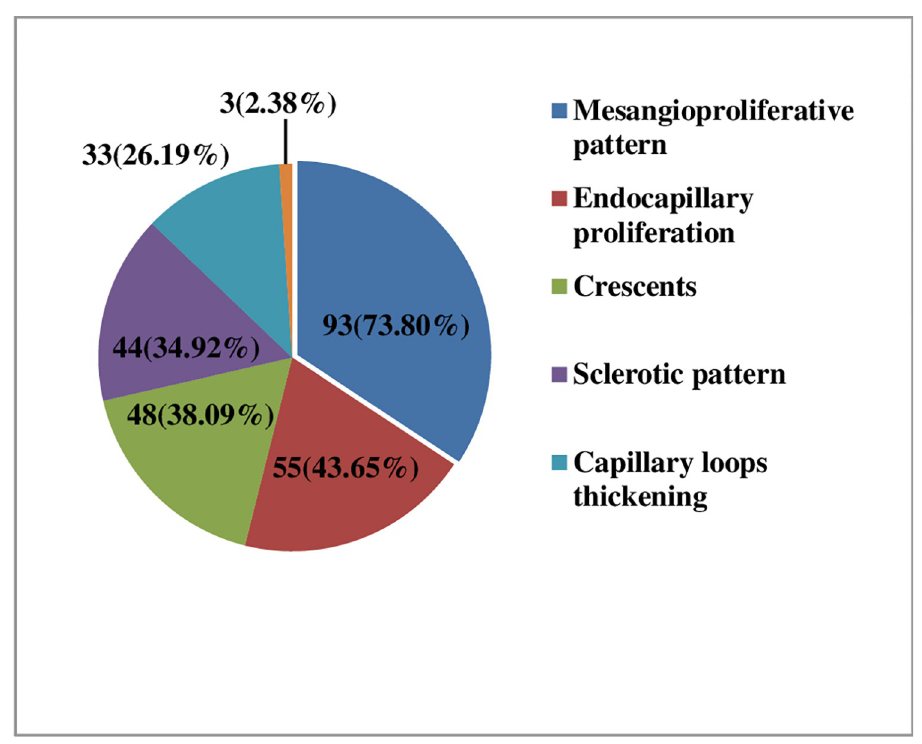
Fig 3. Histopathological findings in